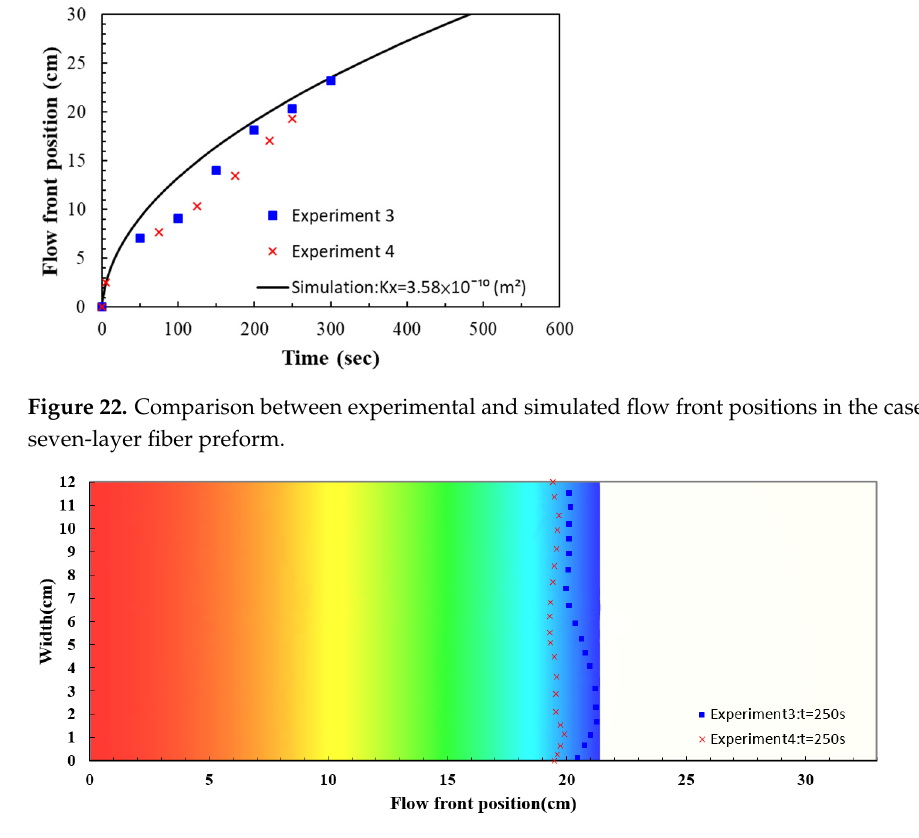
Figure 23. Snapshot of flow front positions at the 250th second in the case study of seven-layer fiber preform .